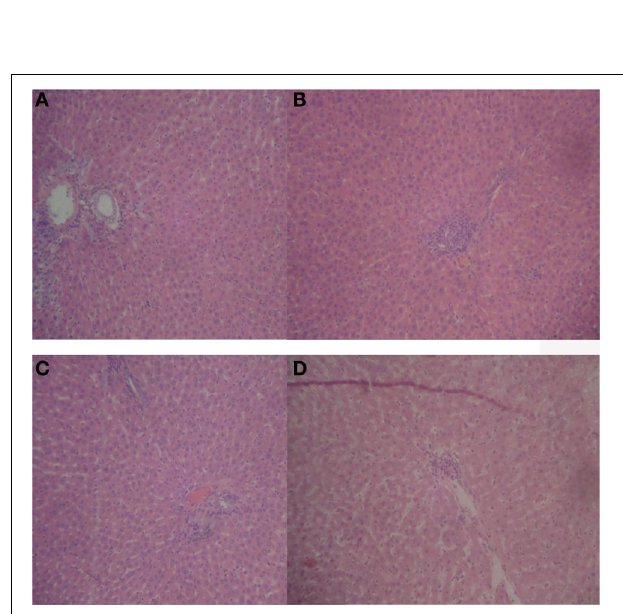
FIGURE 2 | Representative sections of rat liver in respect of 60 days treatment. (A) Normal rat liver showing normal hepatic architecture; (B) 20mg/kg/day HLE-FP-treated rat liver showing patchy areas of lymphocytic infiltrations; (C) 100mg/kg/day HLE-FP-treated rat liver showing mild vascular congestion; and (D) 500mg/kg/day HLE-FP-treated rat liver showing scattered areas of lymphocytic aggregates with mild sinusoidal congestion signifying mild-to-moderate inflammation ( × 100 magnification).